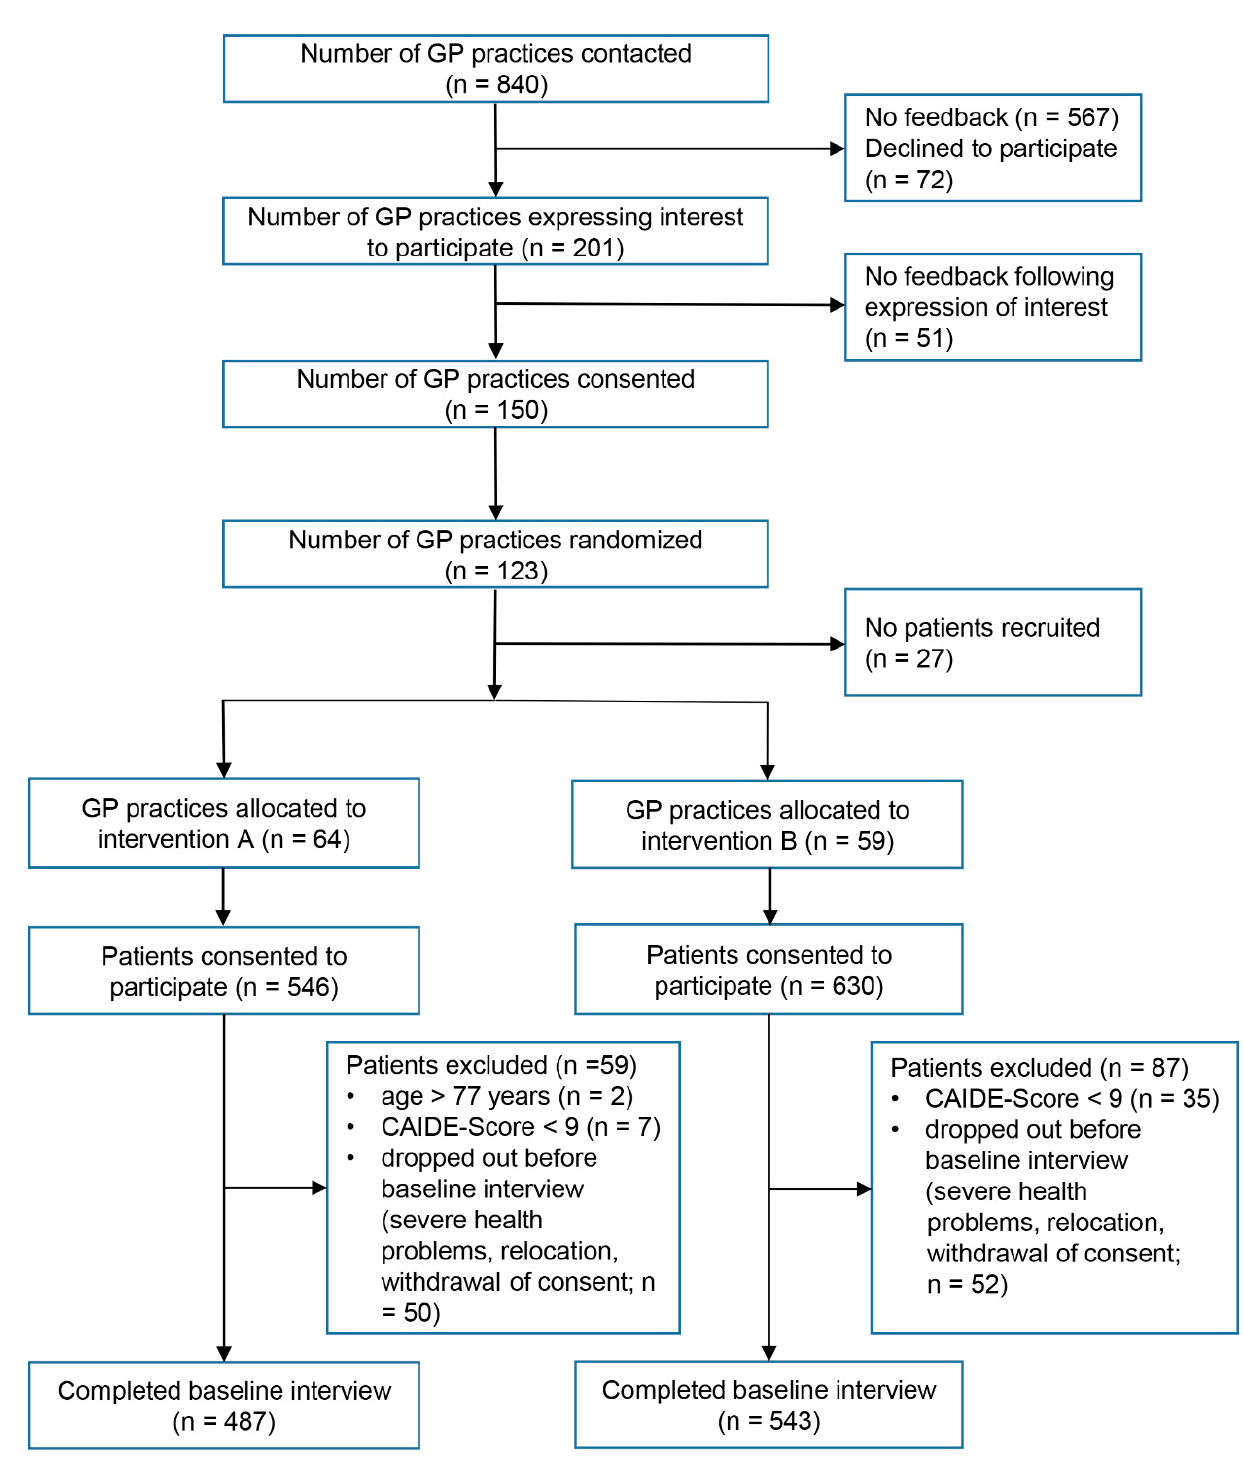
Figure 1. Recruitment process and sample selection of participants in the AgeWell.de trial.